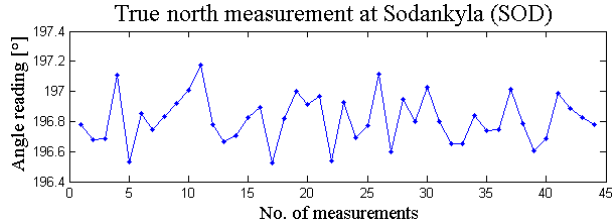
Figure 5. Series of true north measurements (trace on horizontal circle) at Sodankylä magnetic observatory. The angle readings cor- respond to horizontal circle value when instrument is pointing true north.